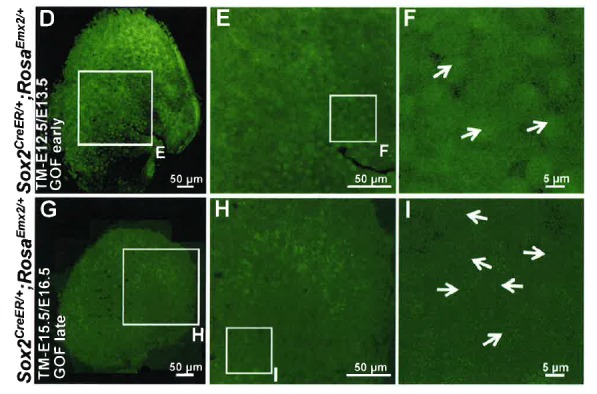
DOI:
http://dx.doi.org/10.7554/eLife.23661.028